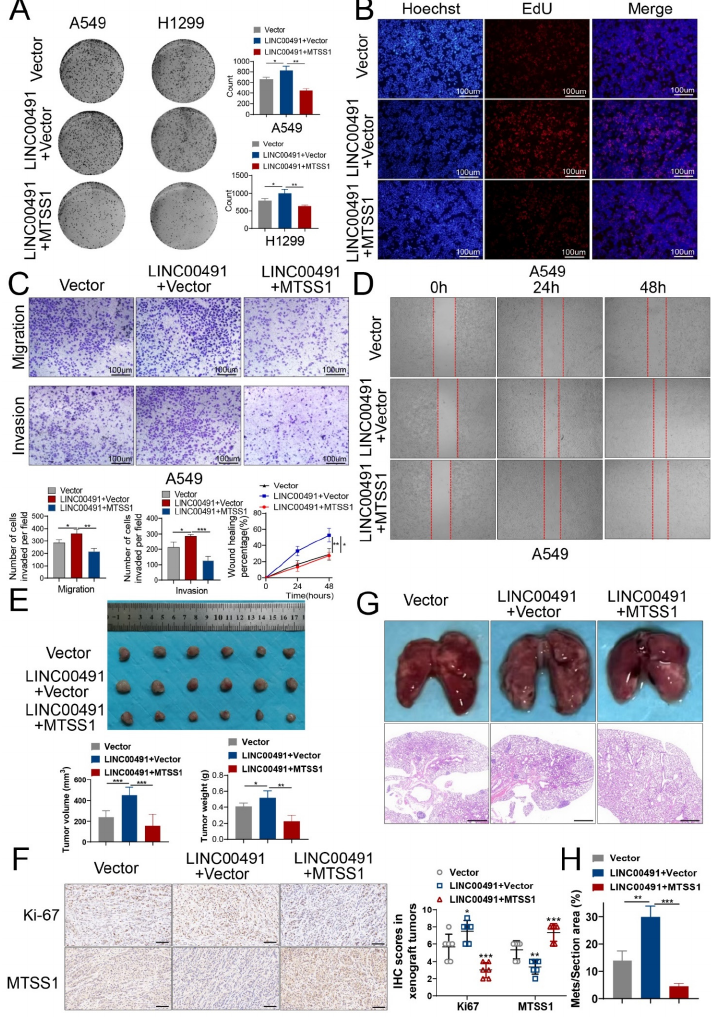
Figure 5. MTSS1 reverses the effects of LINC00491 on LUAD proliferation, migration, invasion and metastasis in vitro and in vivo. ( A ) Representative images of colony formation assays indicated that the overexpression of MTSS1 reversed the growth promotion effect of LINC00491’s overexpression in LUAD cells. Quantification of results is exhibited in the right panel. ( B ) The proliferation ability measured by EdU assays showed that overexpression of MTSS1 reversed the growth promotion effect of LINC00491’s overexpression in A549 cells. Scale bars = 100 µ m. ( C ) Transwell assays showed that the overexpression of MTSS1 reversed the migrative and invasive capacity promoted by LINC00491’s overexpression in A549 cells (upper panel). Quantification of results is exhibited in the bottom panel. Scale bars = 100 µ m. ( D ) Representative images of the scratch wound healing assay showed that the overexpression of MTSS1 reversed the migrative capacity promoted by LINC00491’s overexpression in A549 cells. Quantification of results is exhibited in the bottom panel. ( E ) Representative images of xenograft tumors in nude mice from mock plasmids, LINC00491 and mock plasmids, and LINC00491 and MTSS1 groups ( n = 6), the analysis of tumor volume and weight is on the bottom. ( F ) IHC of Ki67 and MTSS1 in xenograft tumors (left panel). Analysis of IHC was in the right panel. Scale bars = 50 µ m. ( G ) Representative images of lung metastases in nude mice from mock plasmids, LINC00491 and mock plasmids, and LINC00491 and MTSS1 groups (upper panel). HE staining of lung metastases is in the bottom panel. Scale bars = 100 µ m. ( H ) Analysis of metastatic area in the HE staining. In each experiment, three replicates were conducted. Data are presented as the mean ± SD. *, p < 0.05; **, p < 0.01; ***, p <